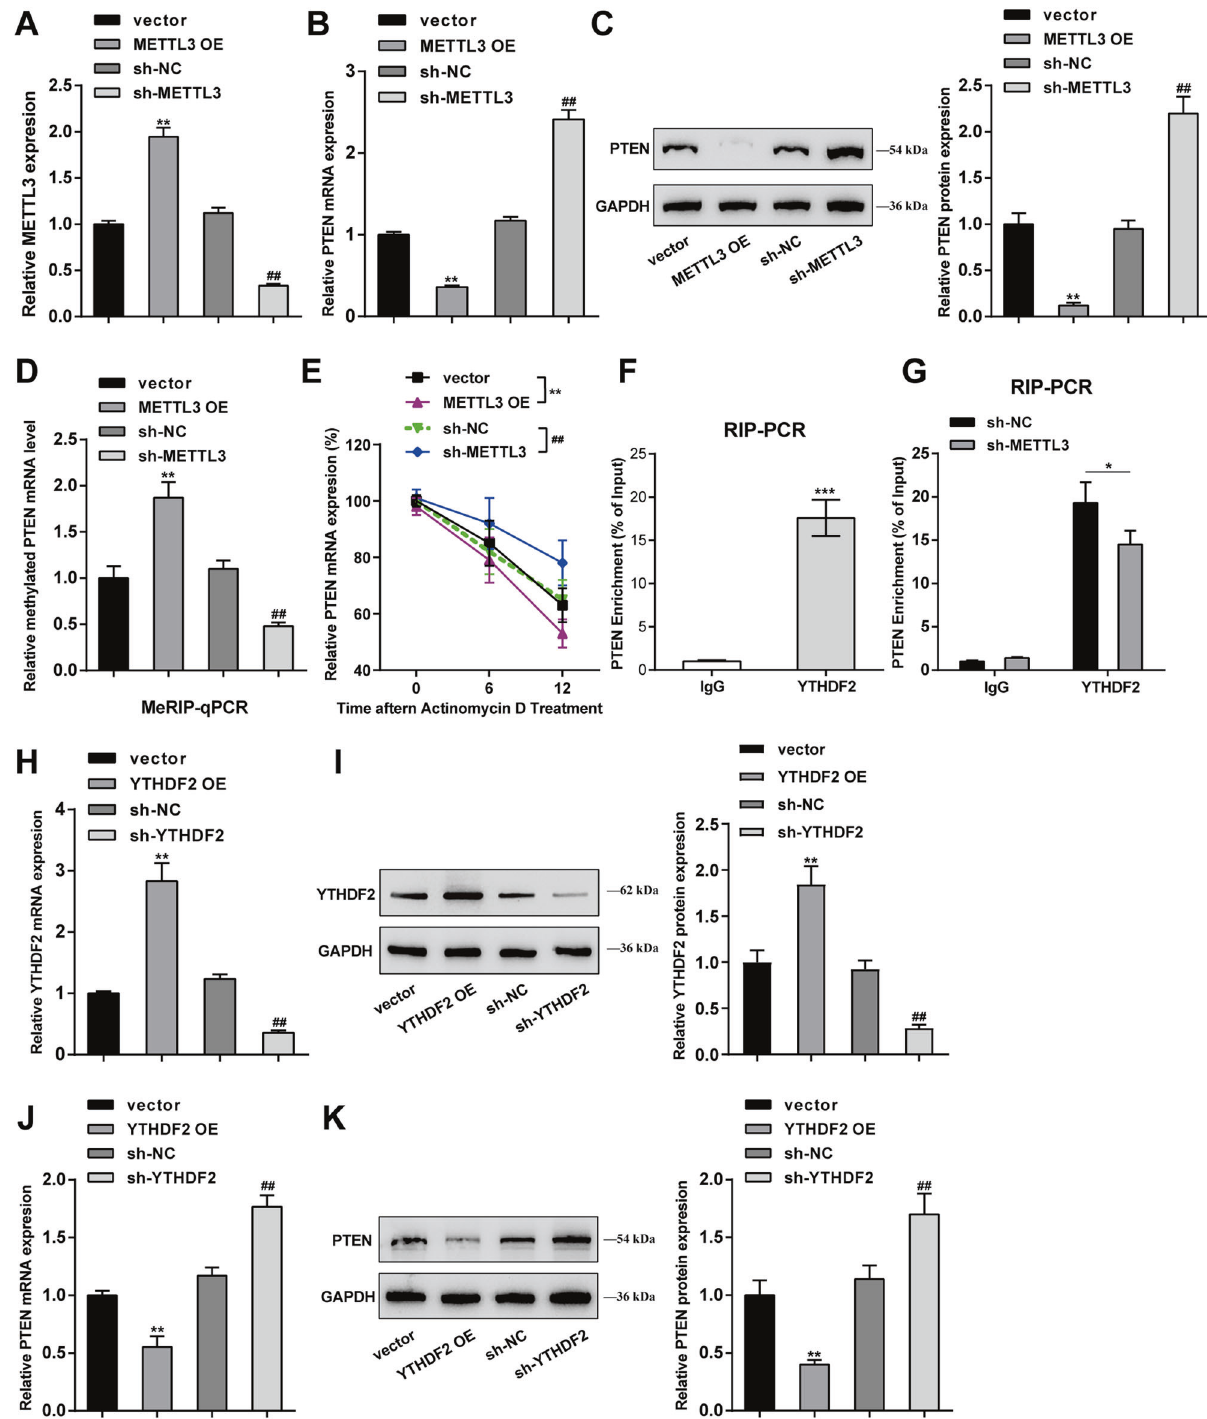
Fig. 5 METTL3 mediates m6A modi fi cation of PTEN and regulates its expression through reading protein YTHDF2. A METTL3 overexpression or knockdown was achieved in BPH-1 cells by transfecting OE-METTL3 or sh-METTL3 and con fi rmed using qRT-PCR. BPH-1 cells were transduced with OE-METTL3 or sh-METTL3 and examined for PTEN mRNA expression using qRT-PCR ( B ); PTEN protein levels using Immunoblotting ( C ). The m 6 A modi fi cation status of PTEN using Me-RIP assay ( D ); PTEN mRNA synthesis using actinomycin D assay ( E ). ** P < 0.01, compared with the vector group; ## P < 0.01, compared with the sh-NC group. F The binding between YTHDF2 and PTEN was validated in BPH-1 cells using RIP assay with anti-IgG and anti-YTHDF2. *** P < 0.001, compared with the anti-IgG group. G The binding between YTHDF2 and PTEN was validated in sh-NC or sh-METTL3 transduced BPH-1 cells using RIP assay with anti-IgG and anti-YTHDF2. * P < 0.05, compared with the sh-NC group. ( H , I ) YTHDF2 overexpression or knockdown was achieved in BPH-1 cells by transfecting OE- YTHDF2 or sh-YTHDF2 and con fi rmed using qRT-PCR and Immunoblotting, respectively. ( J , K ) BPH-1 cells were transduced with OE-YTHDF2 or sh-YTHDF2 and examined for PTEN mRNA expression and protein levels using qRT-PCR and Immunoblotting, respectively. ** P < 0.01, compared with the vector group; ## P < 0.01, compared with the sh-NC